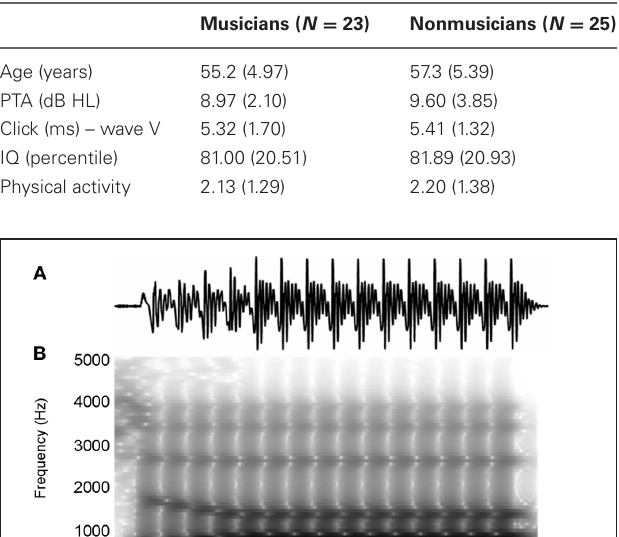
Table 2 | Participant characteristics: means (with SDs) for the musician and nonmusician groups are listed for age, pure-tone averages (0.5–4kHz HL), click wave V latencies, non-verbal IQ percentiles (WASI Matrix Reasoning Subtest), and physical activity.